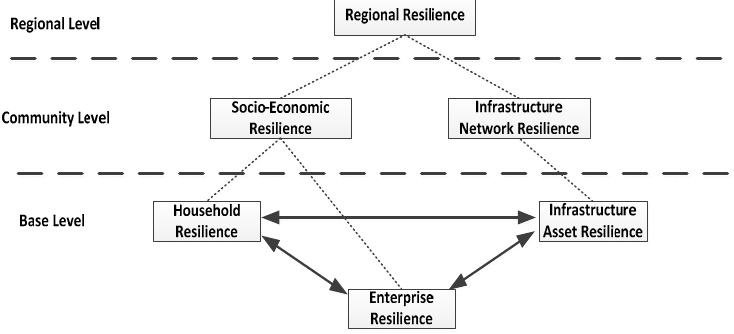
Figure 3. Multi-level aggregation of resilience.